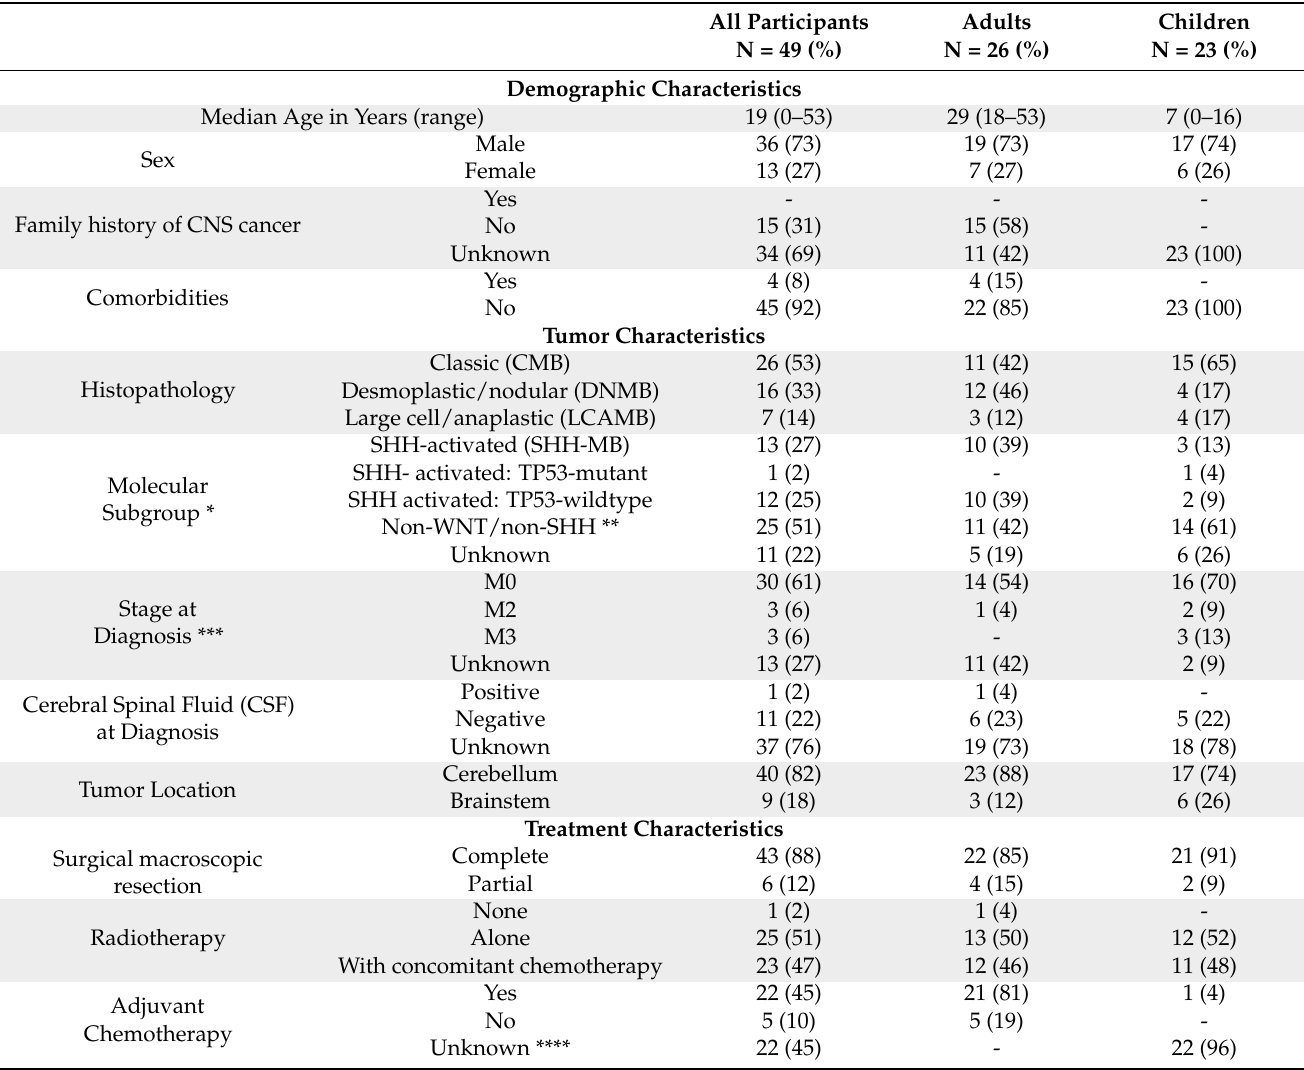
Table 1. Patient, Tumor and Summarized Treatment Characteristics. All